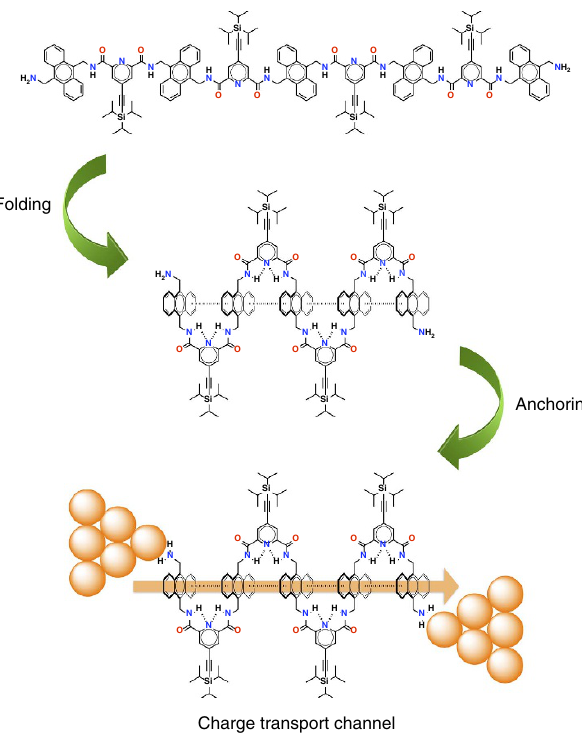
Figure 1 | p -Folded molecular junctions. Schematic representation of the folding and anchoring processes needed to obtain p -folded molecular junctions from a representative member of the foldamer family studied in this